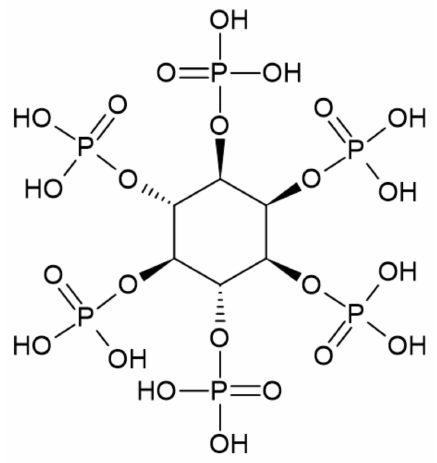
Figure 13. The structure of phytic acid